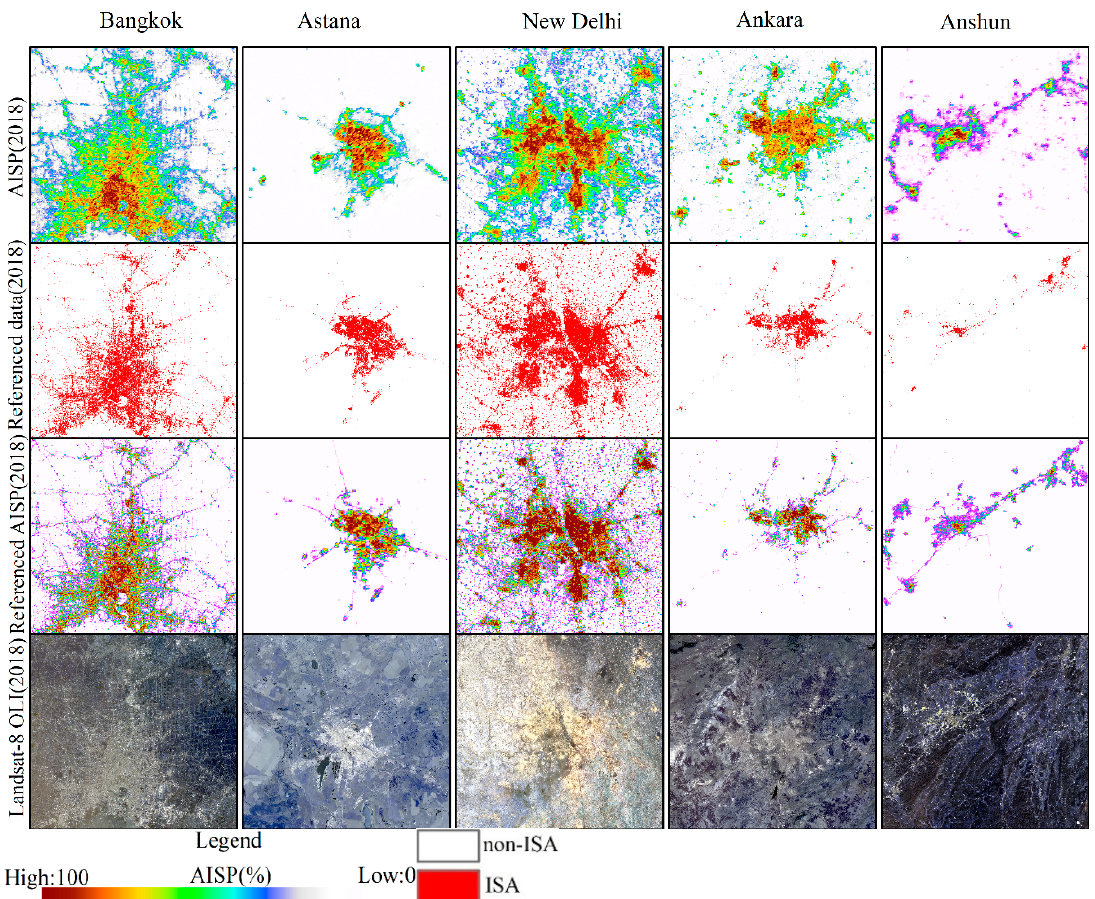
Figure 7. The result of predicted AISP derived from scheme 4 using 80% of samples as training data in typical cities (reference data from Landsat 8; AISP denotes the artificial impervious surface percentage).